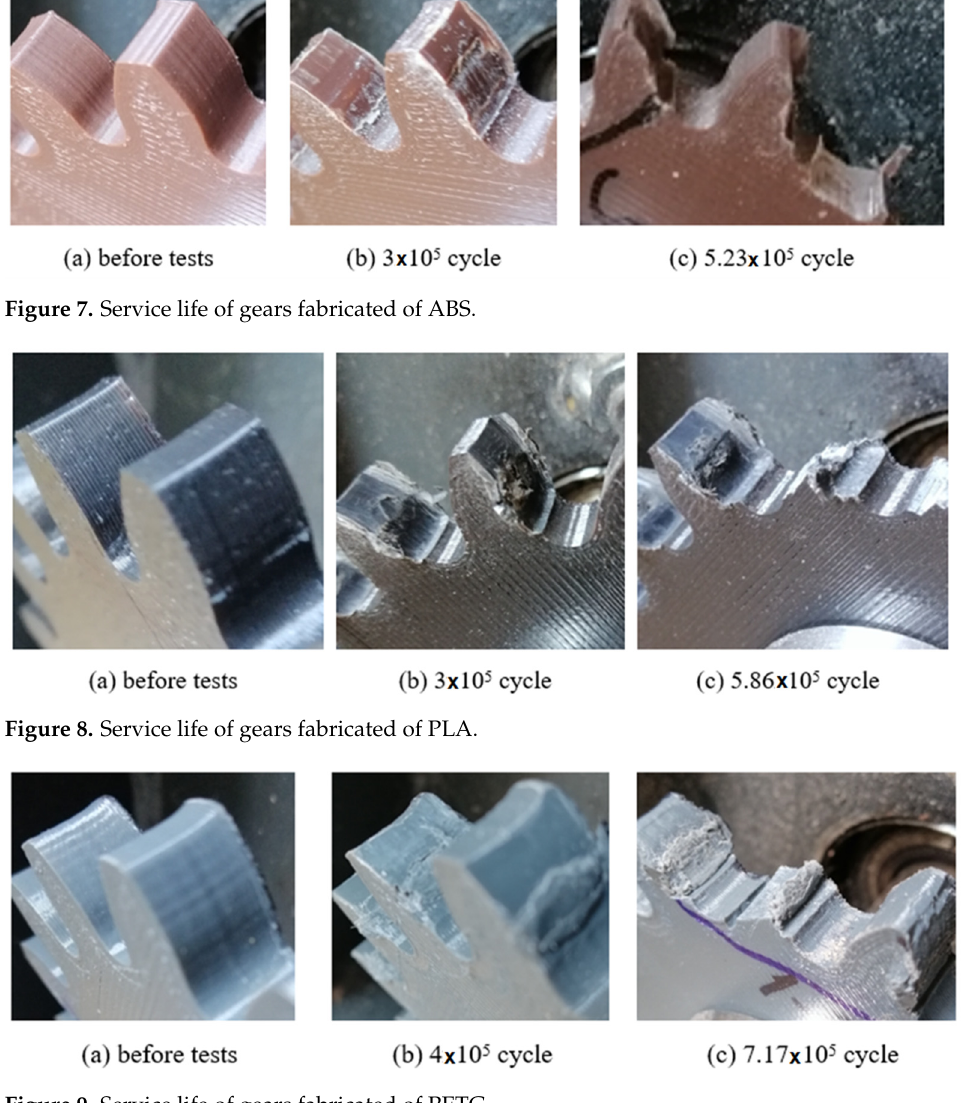
Figure 9. Service life of gears fabricated of PETG.